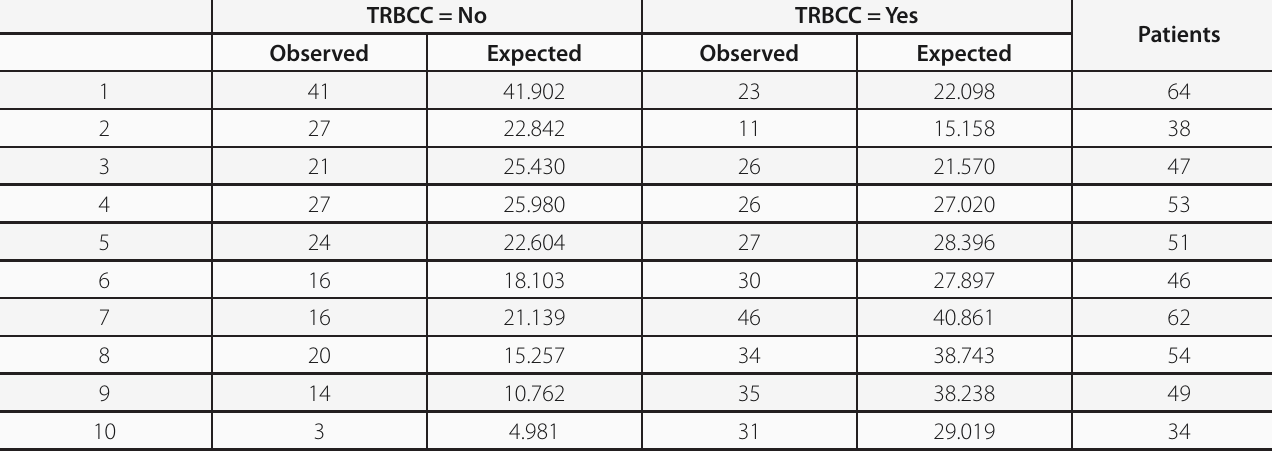
Table 5. Observed and expected transfusion using TRACK score as predictor in groups defined in the Hosmer-Lemeshow test. TRBCC = No TRBCC = Yes